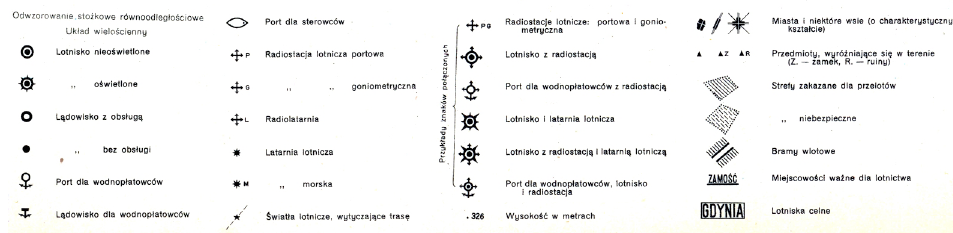
Fig. 3. Part of an aeronautical chart at the scale of 1:500,000 from the territory of